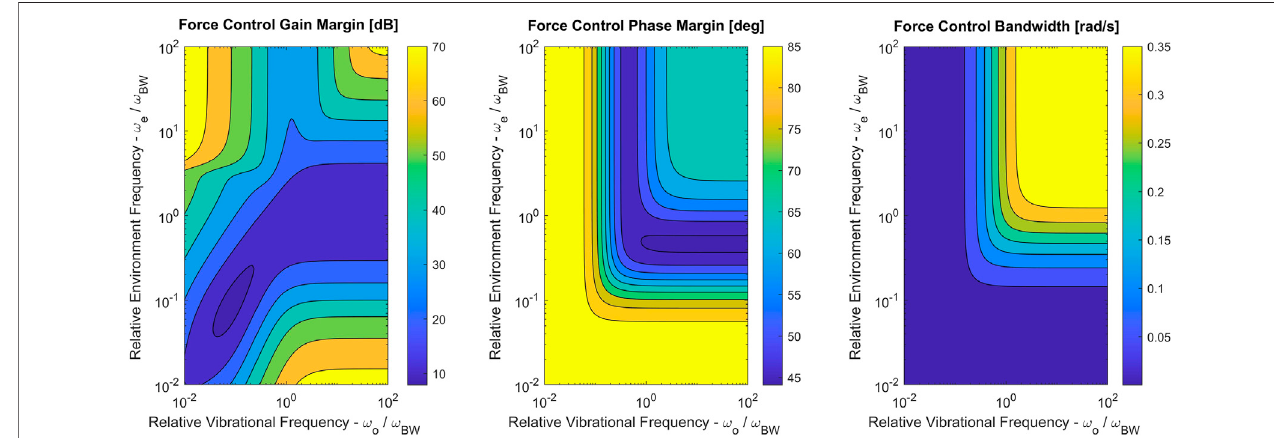
FIGURE 15 | Force control gain margin, phase margin and bandwidth for the perturbed system with different values of ω e ∈ {0.01,100} and ω o ∈ {0.01,100} (both sampled evenly in log-space). Perturbation parameters were set to α (cid:2) 0.9 and ξ (cid:2) 0.04.